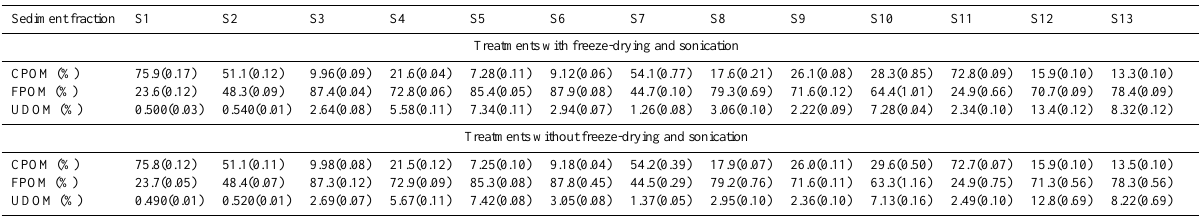
Table 2. Average weight percents (%) of the three sediment fractions at the sampling stations with and without the treatment of freeze-drying and